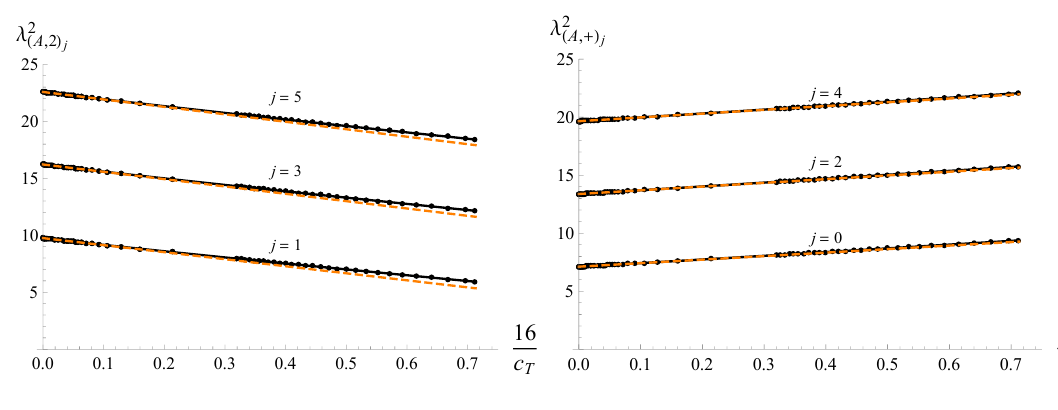
Figure 1 . The (cid:21) 2 and (cid:21) 2 OPE coe(cid:14)cients with spins j = 1 ; 3 ; 5 and j = 0 ; 2 ; 4, ( A; 2) j ( A; +) j respectively, in terms of the stress-tensor coe(cid:14)cient c T , where the plot ranges from the generalized free (cid:12)eld theory limit c T ! 1 to the numerical point 16 (cid:25) : 71 where (cid:21) 2 = 0, which is near ( B; 2) c T the lowest interacting theory ABJ 1 with c T = : 75. The orange dotted lines show the analytic 1 =c T corrections (4.22) and